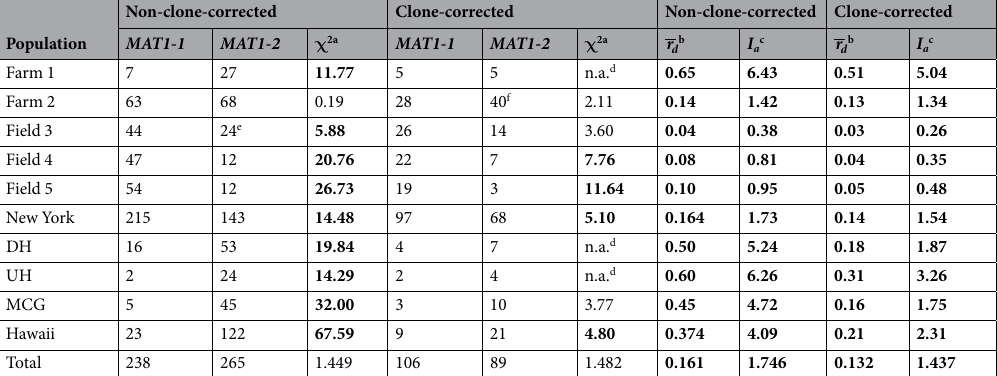
Hawaii 23 122 238 Table 6. Tests of linkage equilibrium of microsatellite loci and mating-type frequencies for Cercospora beticola populations collected from New York and Hawaii, in 2015. a χ 2 value based on 1:1 ratio and one degree of freedom. Values related to mating-type frequencies with significant deviation from one ( P < 0·05) are indicated in bold; b r d = standardized index of association scaled for the number of loci with significant deviations from zero ( P < 0.05) indicated in bold; c I a = index of association with significant deviations from zero ( P < 0.05) indicated in bold; d n.a. = not applicable or not calculated due to small sample sizes; e isolate Tb15-056 (from Field 3) failed to amplify a band after three PCRs, hence the total number of isolates from this field was 68 (rather than 69); f three pairs of isolates with identical microsatellite genotypes in Farm 2 belonged to alternate mating-types, hence the total isolates for the clone corrected data set is 68, which was larger than the number of MLGs in this farm